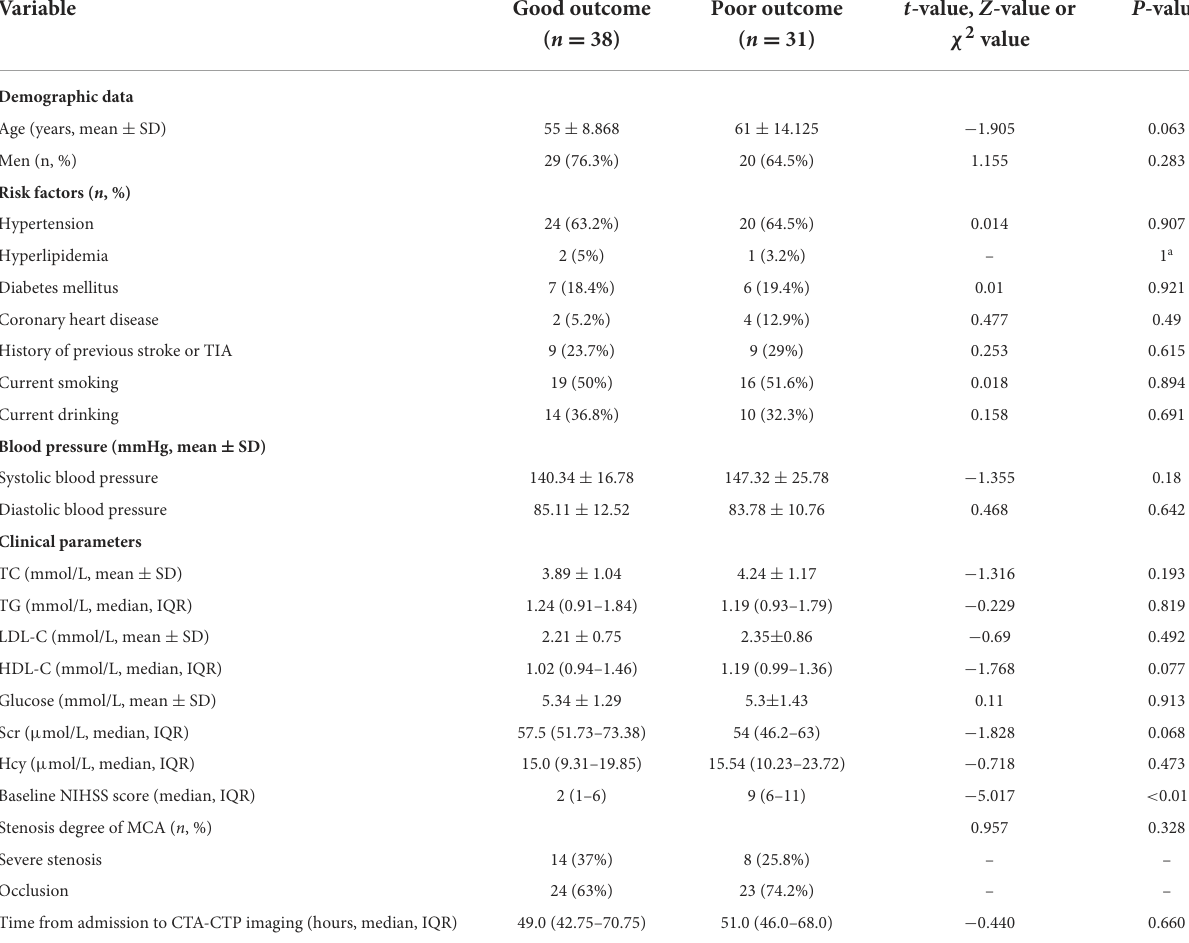
TABLE 1 Patient baseline demographic and medical characteristics. Variable